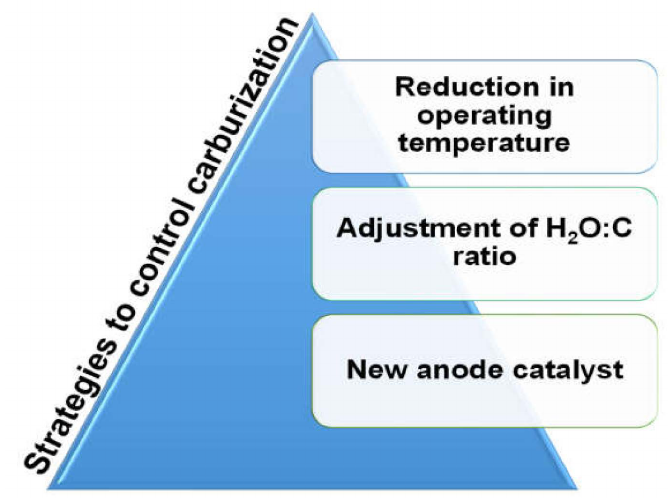
Figure 5. Strategies to control